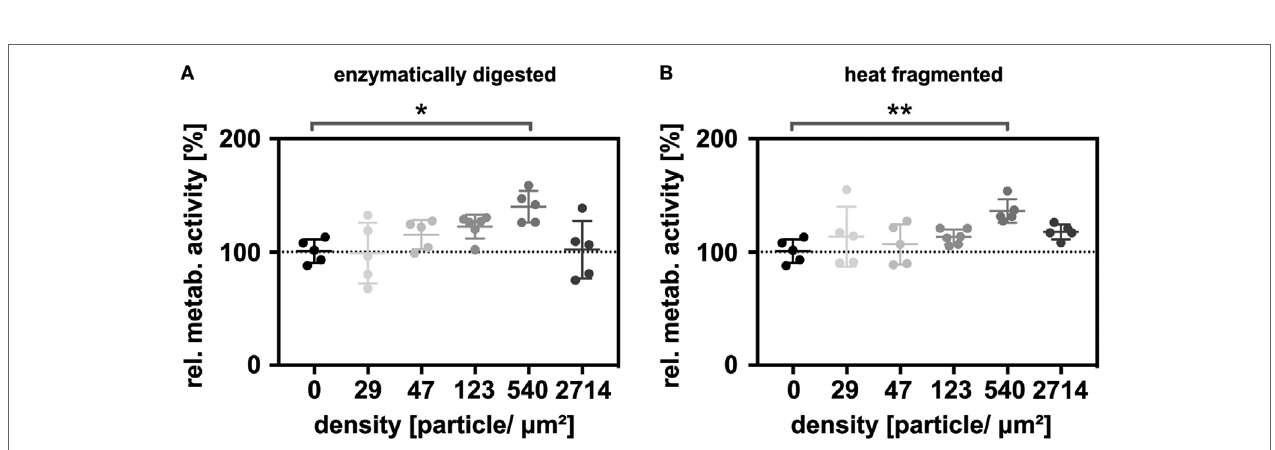
FigUre 3 | Immobilized HA oligosaccharides (sHA) exerting a biphasic effect on the metabolism of lymphatic endothelial cells (LECs). Graphs show the relative metabolic activity of LECs normalized to the relative amount of DNA on the surface for (a) the immobilized, enzymatically digested sHA and (B) the immobilized, heat-fragmented sHA species. To analyze the significance of the results, a Kruskal–Wallis test followed by the Dunn’s multiple comparison was carried